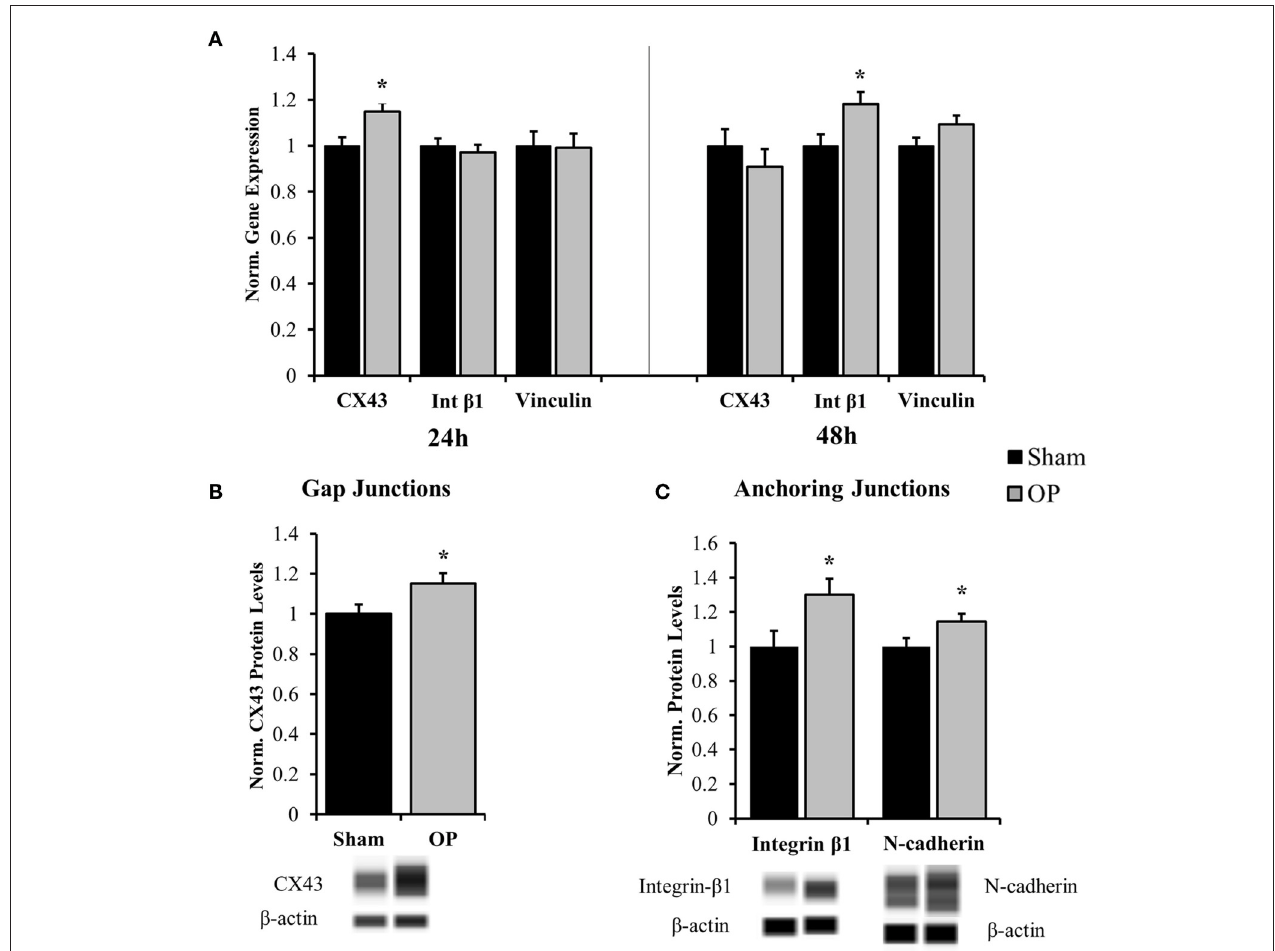
FIGURE 5 | Gene and protein expression for cell junction targets. (A) Gene expression analysis showed increased gap junction (CX43) regulation at 24h after high-rate overpressure and increased anchoring junction (integrin) regulation at 48h as compared to sham. No changes were observed in vinculin mRNA expression. (B) Western blot results confirmed increased protein levels of CX43 at 24h after overpressure as compared to sham. (C) Anchoring junction proteins integrin- β 1 and N-cadherin were significantly elevated as compared to sham at 48h after overpressure. * p < 0.05, Data are represented as mean ± SEM, gene: n = 7–9/group, protein: n =